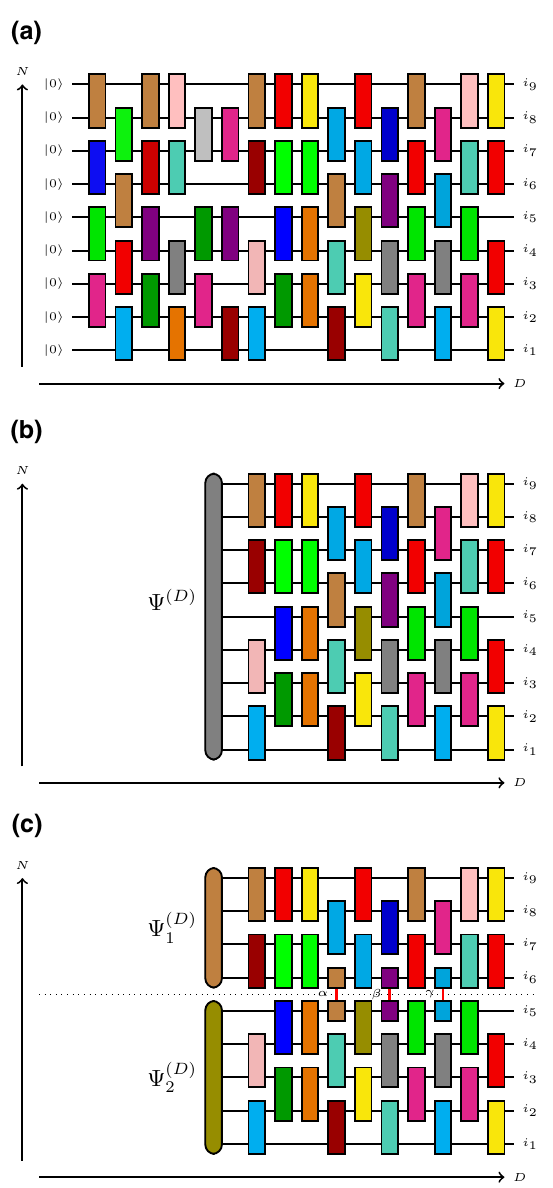
FIG. 14. Schematic of two contraction strategies for simu- lating a quantum circuit. (a) Quantum circuit to contract. (b) Schrödinger-like simulation. (c) Schrödinger-Feynman-like sim-